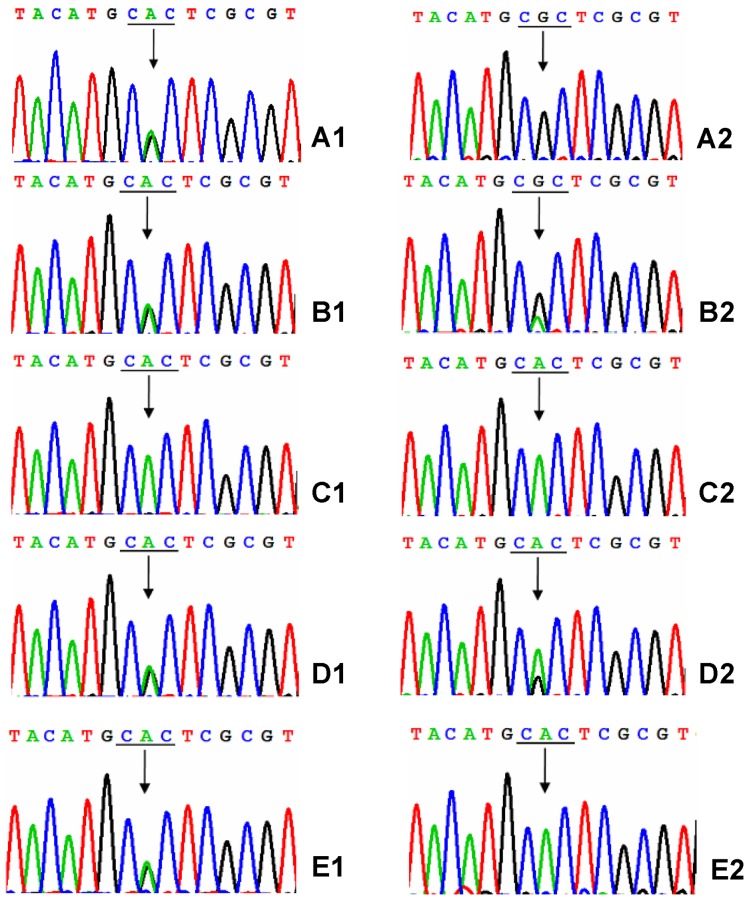
Sequence analysis in genomic DNA and cDNA of the female members.Genomic DNA sequencing showed a heterozygous pattern of the A-to-G-transition in II5, II3, I 1 and III2 (A1, B1, D1 and E1), but not in II7 (C1). cDNA sequencing showed solely or mainly the mutant allele to be expressed in II5 and II3 (A2 and B2), while solely or mainly the wild-type allele to be expressed in III2 and I 1 (E2 and D2). The position of codon is underlined and the arrow indicates the mutated base.